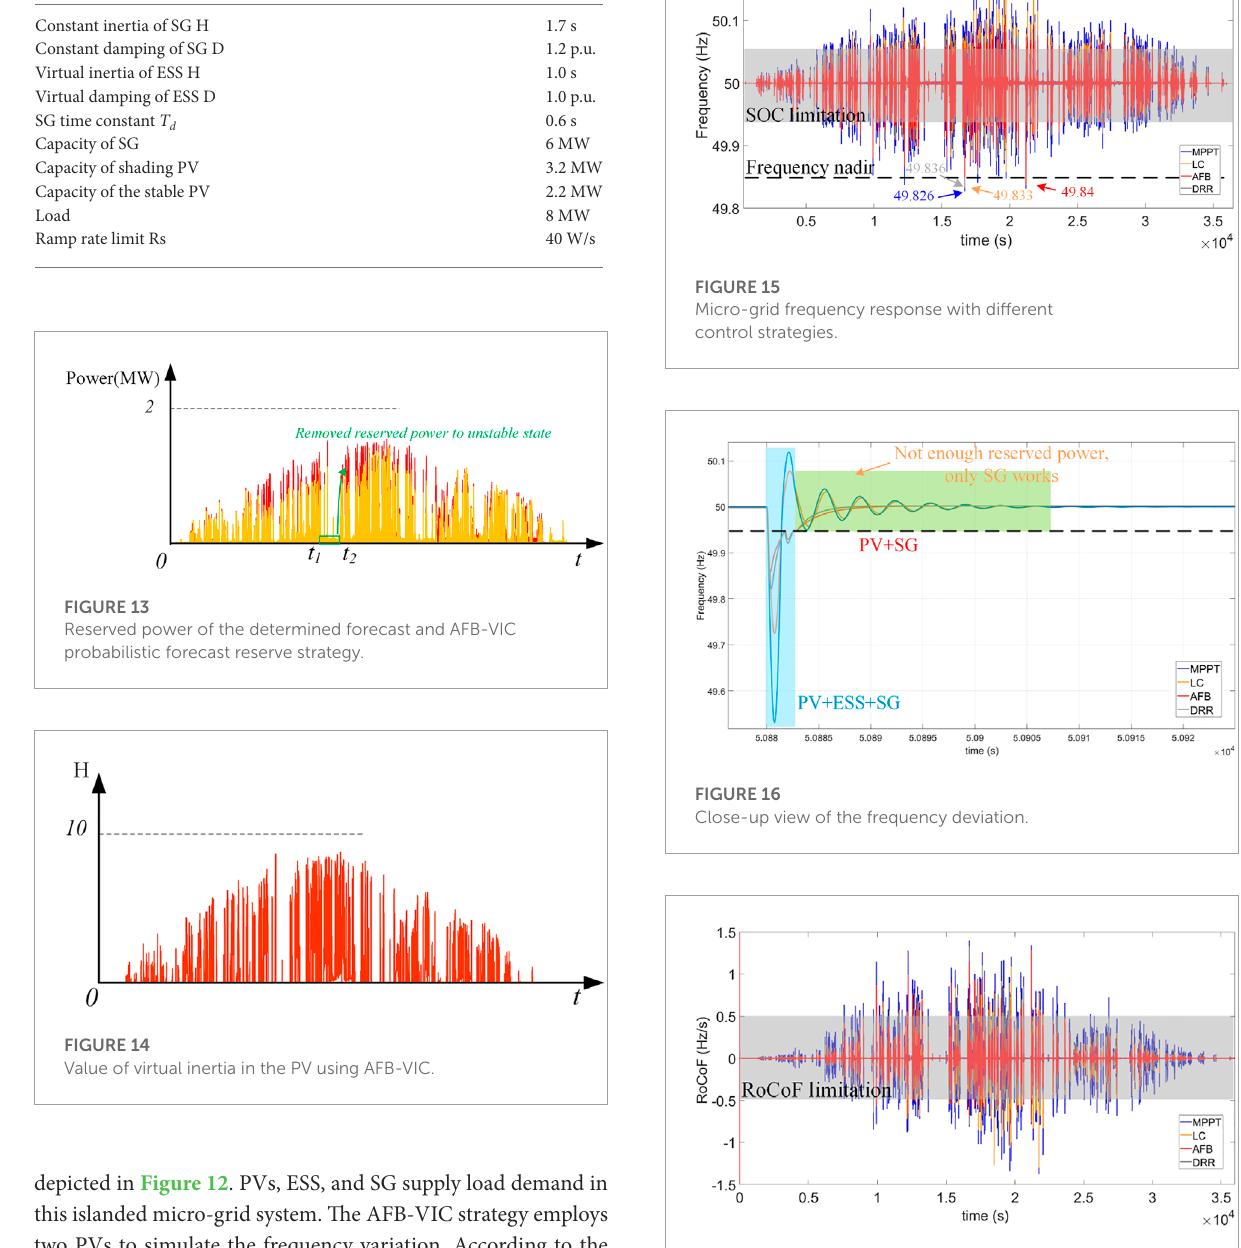
FIGURE 17 RoCoF